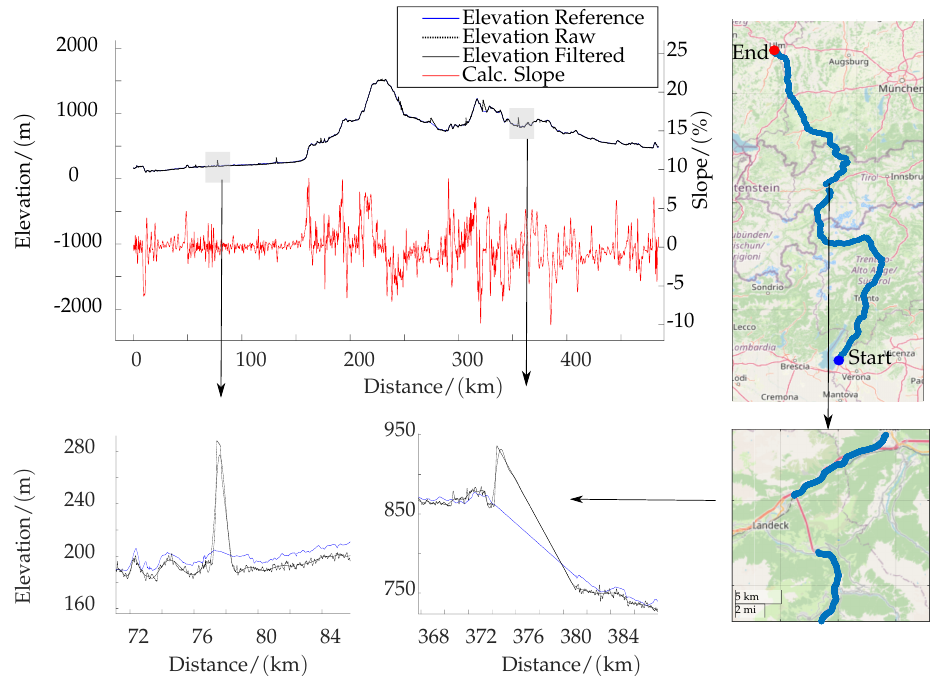
Figure 11. Two-step filter methodology for road slope calculation using an alps traverse journey. The raw elevation signal from interpolated SRTM data is represented by a black dotted line. Applying the first filter algorithm, the filtered elevation signal is calculated (black solid line). Elevation Reference signal is represented by a blue solid line. The resulting calculated road slope from the Elevation Reference signal after applying a Butterworth filter is visualized by the red solid line.